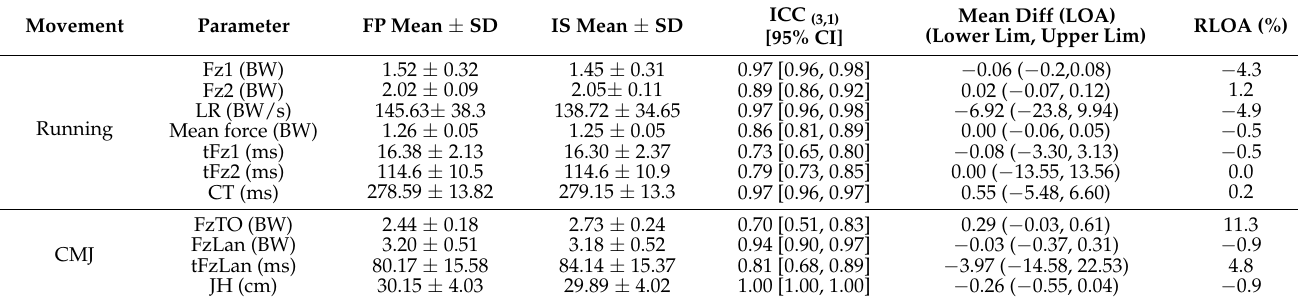
Table 2. Force platform (FP) and instrumented shoe (IS) mean results with standard deviations, intraclass correlations (ICC) values, limits of agreement (LOA) and ratio of limits of agreement (RLOA) for running and countermovement jumps